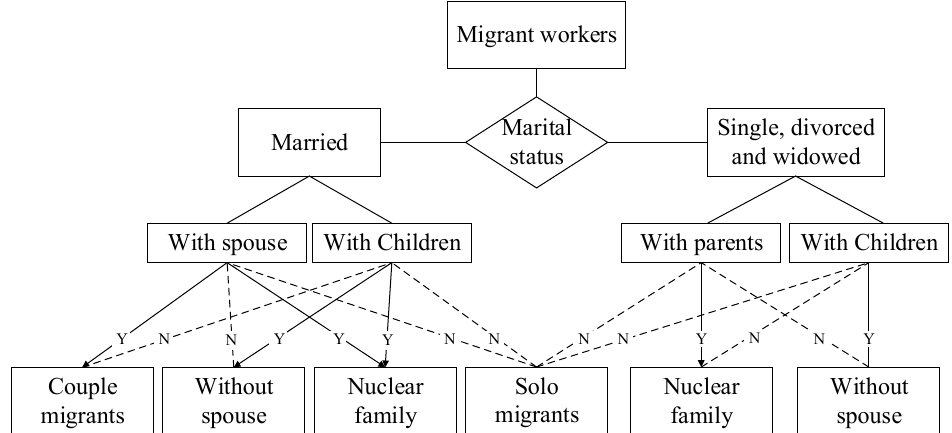
Figure 2. Family living arrangements.